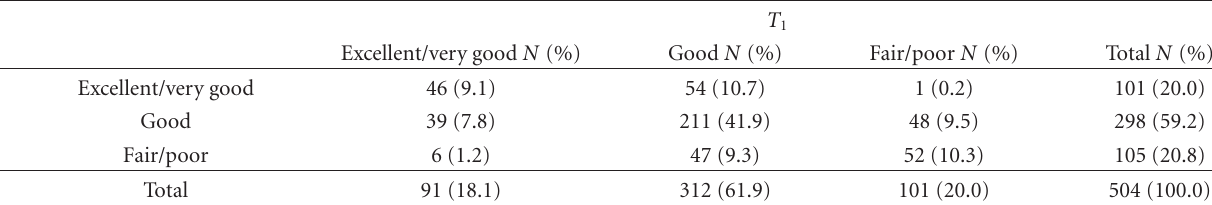
Table 3: Health in general at baseline ( T 0 ) and after one year ( T 1 ) in